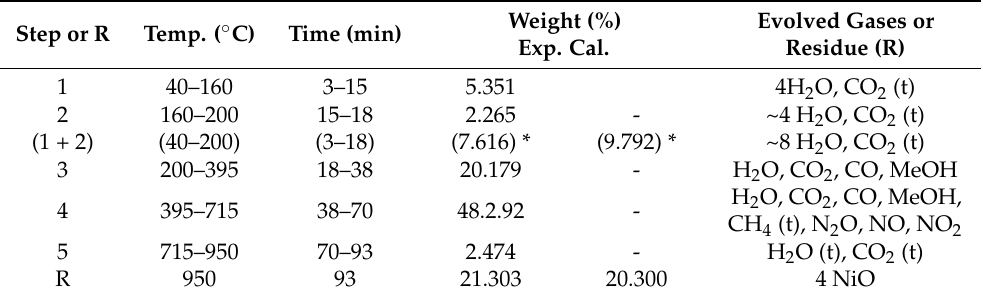
Figure 8. Weight loss versus temperature (r.t. to 950 °C) in the TGA analysis of 1 (sample: 9.382 mg). Table 3. Summary of results obtained from the thermogravimetric analysis of compound 1